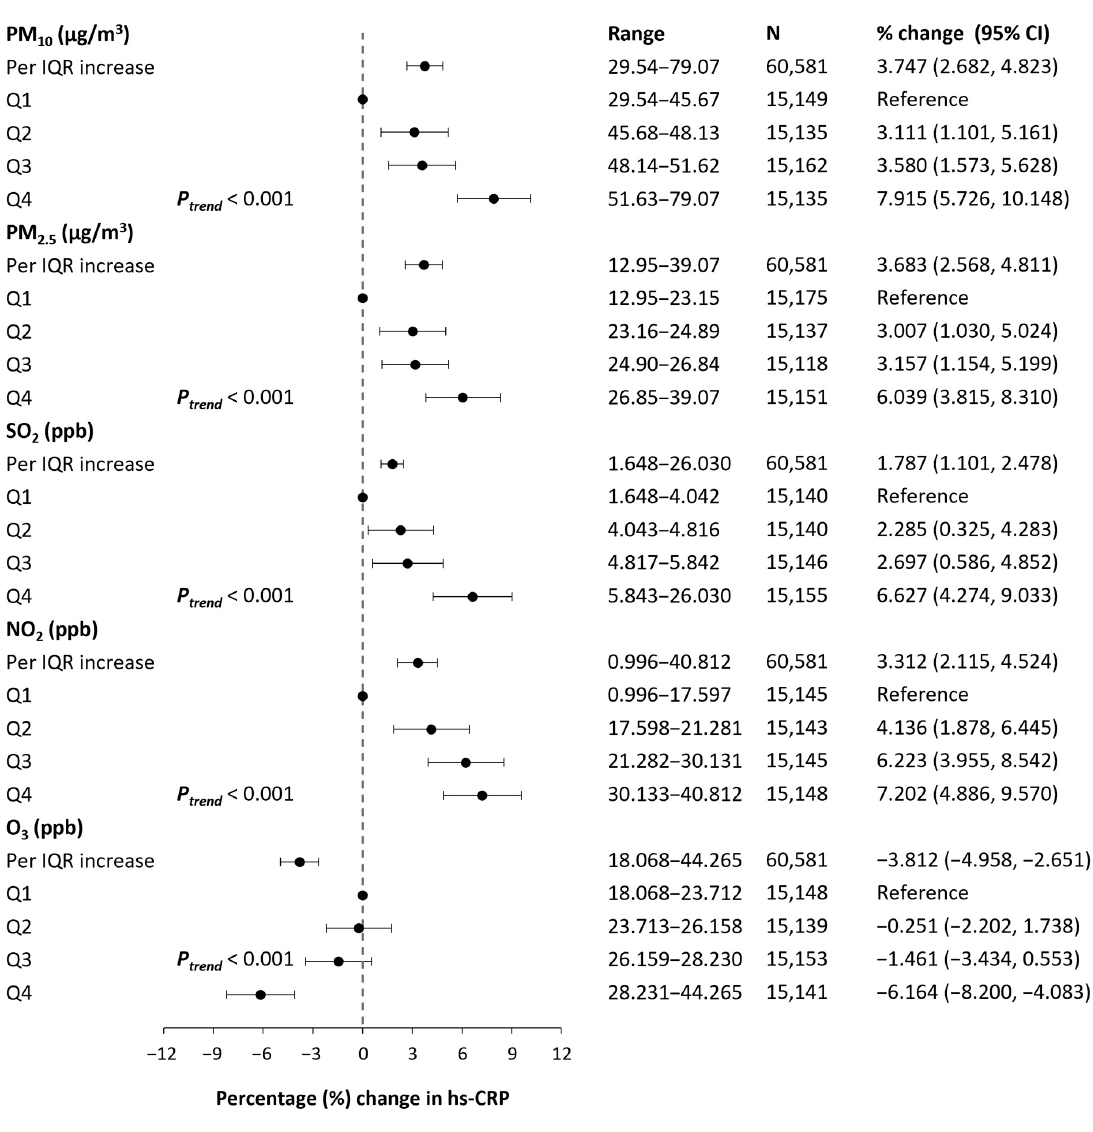
Figure 2. Associations between hs-CRP levels and long-term exposure to air pollutants. The models are adjusted for age, sex, BMI, smoking status, drinking status, regular exercise, occupation, educa- tion, marital status, residential area, year, season, and weekday of examination, medical history of diseases (diabetes, hypertension, dyslipidemia, cardio- and cerebrovascular disease, and cancer), and meteorological factors (2-day moving average of temperature and relative humidity). Estimates are presented as percentage changes with 95% confidence intervals in hs-CRP levels per IQR increase in 2-year average ambient air pollution exposure (corresponding IQR of each pollutant: 5.95 µ g/m 3 for PM 10 , 3.70 µ g/m 3 for PM 2.5 , 1.80 ppb for SO 2 , 12.54 ppb for NO 2 , and 4.52 ppb for O 3 ). PM 10 , PM 2.5 : particulate matter with aerodynamic diameter < 10 µ m and <2.5 µ m, respectively; SO 2 : sulfur dioxide; NO 2 : nitrogen dioxide; O 3 : ozone; Hs-CRP: high-sensitivity C-reactive protein; IQR: interquartile range; Q1, Q2, Q3, Q4: first, second, third, and fourth quartile,